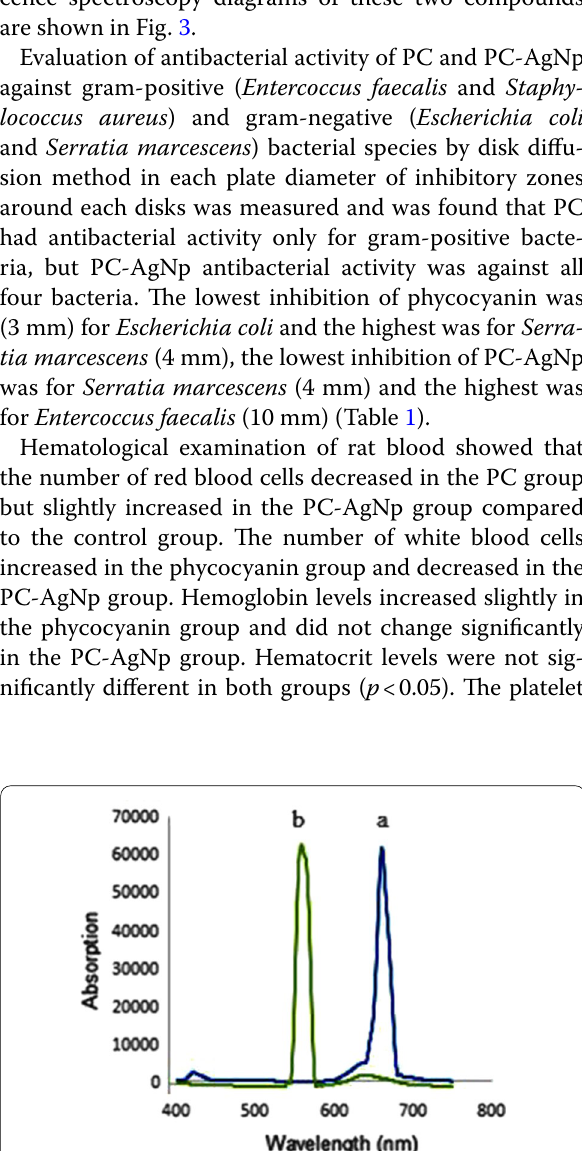
Fig. 3 Fluorescence spectroscopy diagram, a PC, b PC-AgNp, the excitation wavelength was for PC at 620 nm and for PC-AgNp at 540 nm